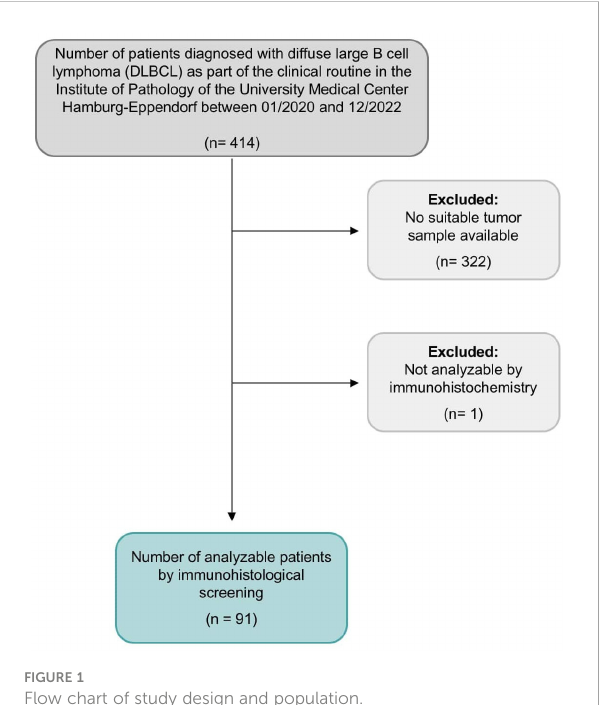
FIGURE 1 Flow chart of study design and